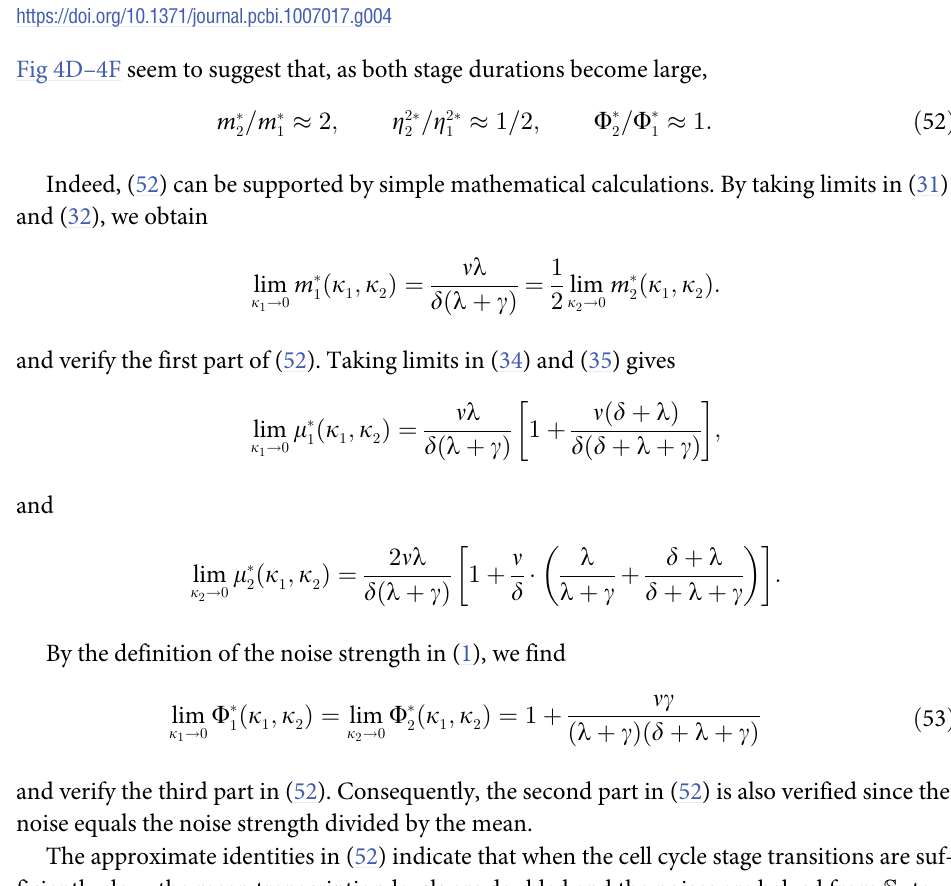
Fig 4. The nonlinear behavior of the transcription noises. The transcription kinetics are specified by (43) and (51), and the stage durations vary from 10 to 10 4 min. (A) The mean m � increases in the cell cycle durations. (B) The noise η 2 � is about equally sensitive to the variation of the stage durations and decreases from 3 to 0.5 as the stage durations increase. (C) The noise strength F � varies widely from 20 to 100 with a highly nonlinear dependance on the stage durations. (D)-(F) The ratios m � = m � , F � = F � 2 ½ 1 ; 2 � , and Z 2 � = Z 2 � 2 ½ 0 : 5 ; 1 � over most durations. (G)-(I) F � is larger 2 1 2 1 2 1 and F � but less than F � þ F � over most than both F � 1 2 1 2